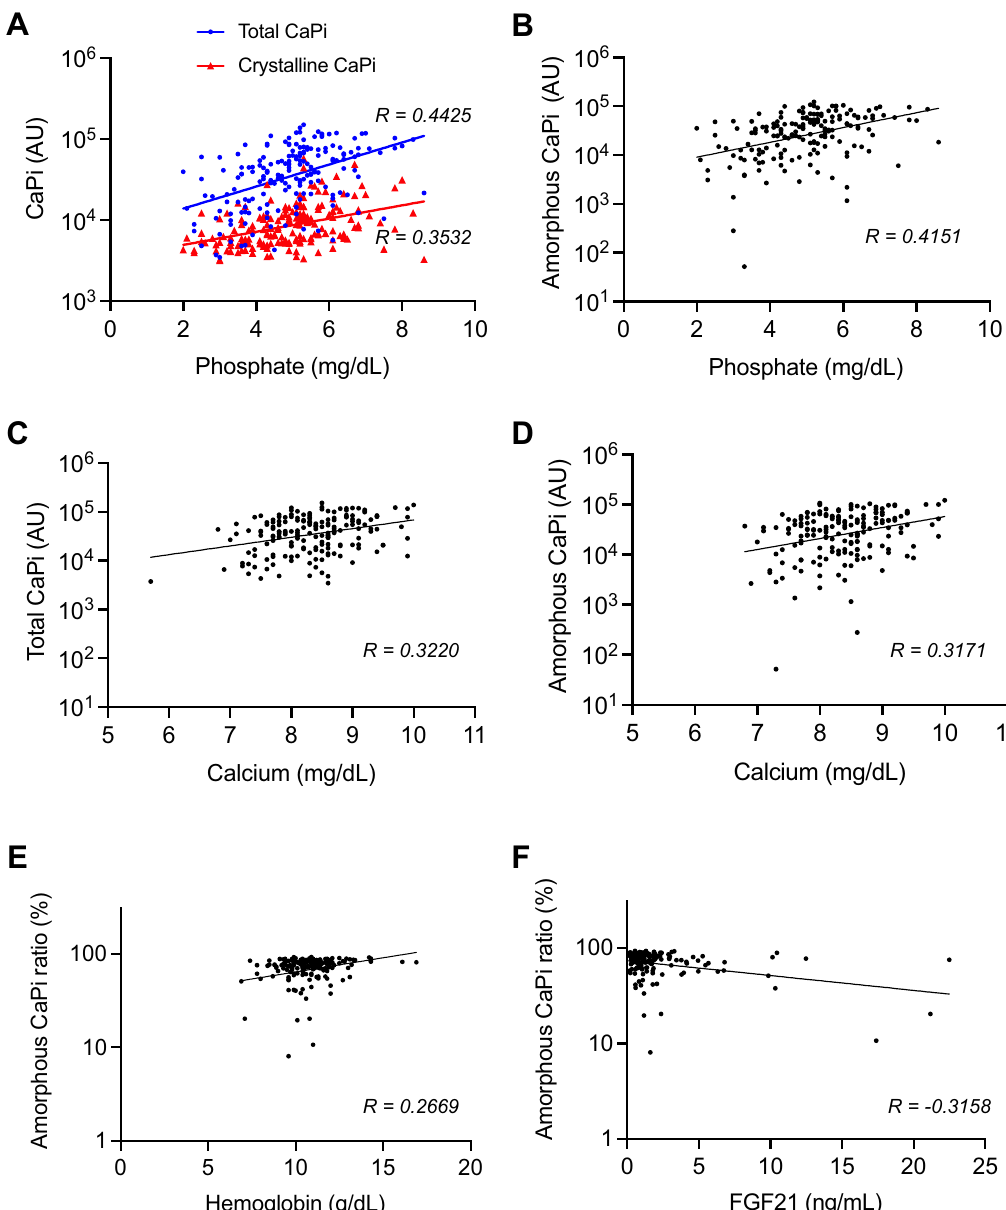
Figure 2. Scattered plots between CPP and other serum parameters. Correlation coefficient (R) is indicated. Association of serum phosphate levels with total ( A , blue), crystalline ( A , red), and amorphous CaPi ( B ) amounts. Association of serum calcium levels with total ( C ) and amorphous ( D ) CaPi amounts. Association of amorphous CaPi ratios with hemoglobin ( E ) and FGF21 ( F